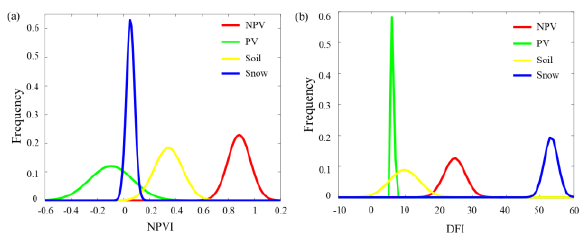
Fig.4 The distribution of NPVI (a) and DFI (b) for the four components